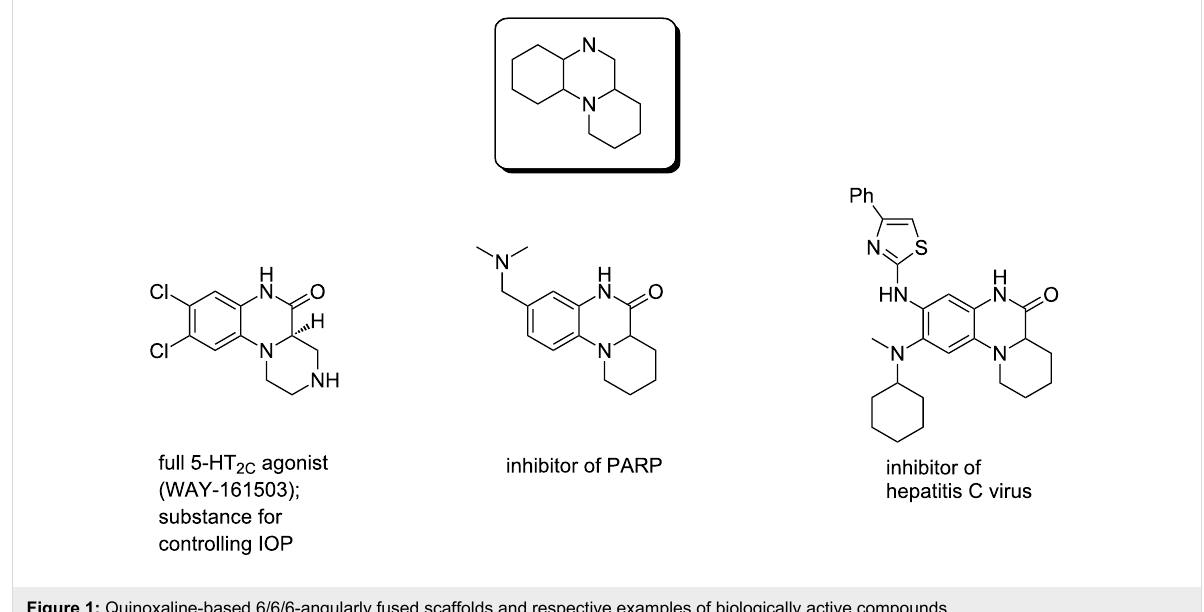
Figure 1: Quinoxaline-based 6/6/6-angularly fused scaffolds and respective examples of biologically active compounds.